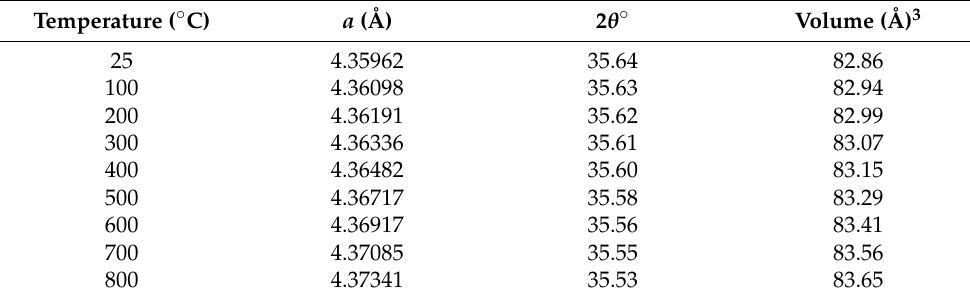
Table 2. The lattice parameters and volume, of 3C-SiC as variant of temperature.